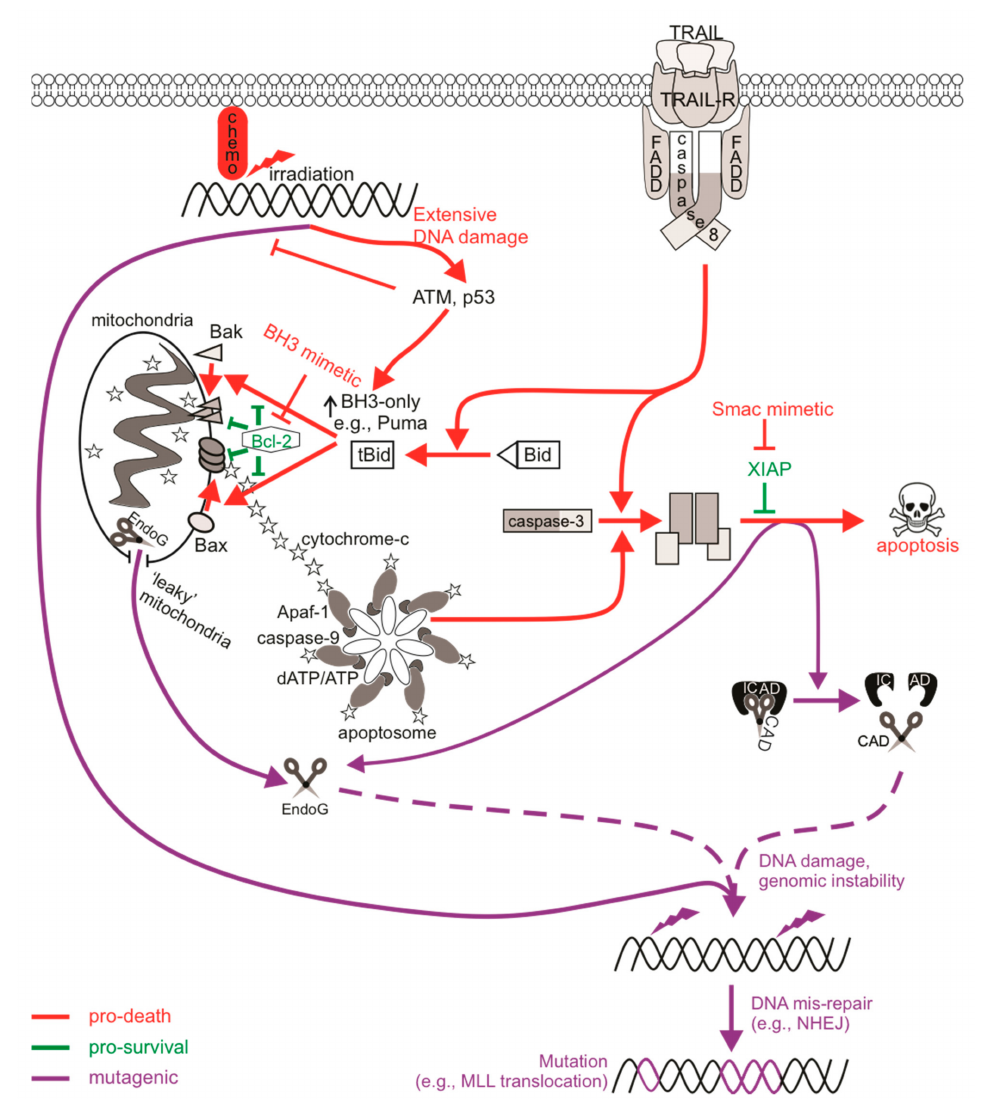
Figure 1. The mutagenic potential of apoptotic signaling. Chemotherapy drugs induce DNA damage that can be recognized by DNA damage sensors such as ATM to direct cell signaling towards DNA repair or death. An insufficient response (for instance, when the ATM function is defective) may encourage the activation of low-fidelity repair pathways such as non-homologous end joining (NHEJ) that are error-prone, increasing the likelihood of genomic mutations. Cell death may also be primed for, leading to p53-mediated upregulation of pro-apoptotic Bcl-2 proteins to induce Bax/Bak-mediated permeabilization of the mitochondrial outer membrane (MOMP), cytochrome c release, and the activation of caspase-9 via the apoptosome. Active caspase-9 can promote executioner caspase activation, which then cleave cellular substrates to induce apoptosis. Extrinsic activation of death receptors can also activate this caspase-cascade. Apoptosis-induced genomic fragmentation by caspase-activated DNase (CAD), which becomes active upon executioner-mediated cleavage of its inhibitor ICAD, can provoke mutations via NHEJ repair if sublethal levels of apoptosis are achieved. BH3 mimetics promote apoptotic cell death by relieving the inhibition of pro-survival Bcl-2 proteins. Some cells may experience “minority” MOMP, which describes the sublethal release of cytochrome c and caspase activation from “leaky” mitochondria. Mutagenesis upon “minority” MOMP can occur due to the release of endonuclease G (EndoG) from the mitochondria and its direct action on DNA or via caspase/CAD-dependent pathways. The mis-repair of nuclease-mediated DNA fragmentation could lead to oncogenic mutations such as chromosomal rearrangements that alter the MLL gene to increase the risk of acute myeloid